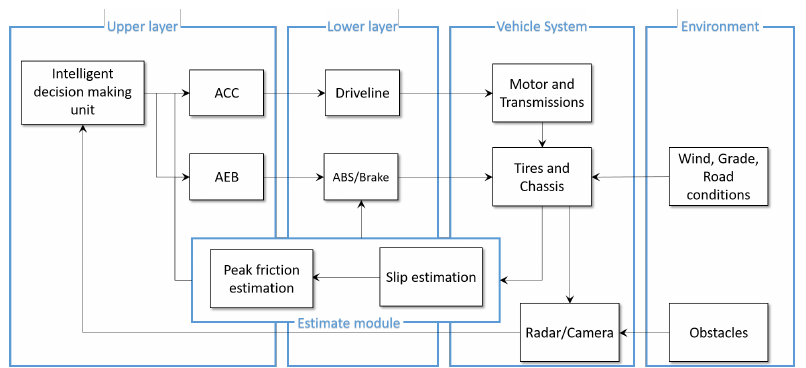
Figure 1. On-board Control